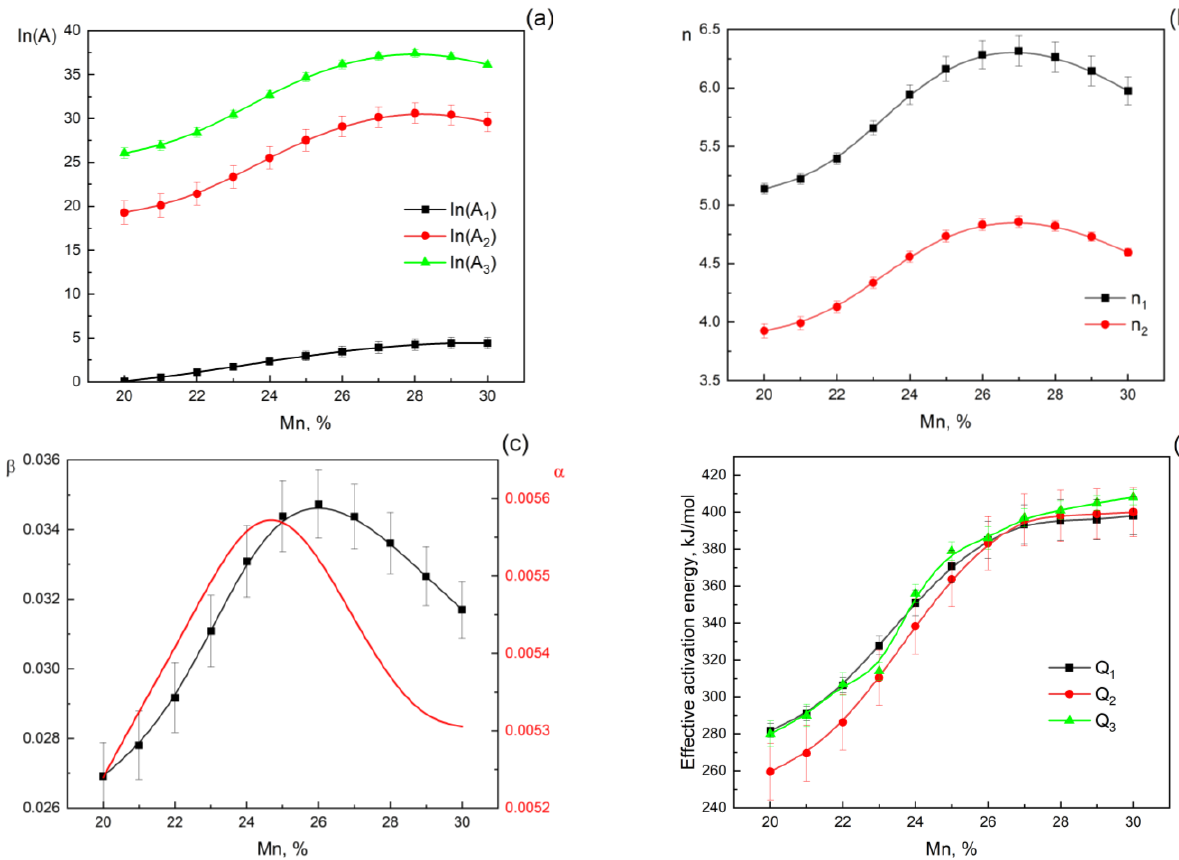
Figure A1. ln(A 2 ), ln(A 3 ) ( a ), n 1 , n 2 ( b ), α, β ( c ), and Q 1 , Q 2 , Q 3 ( d ) on the Mn content in the Fe – xMn – 8Al – 1C steel at a true strain of 0.7.